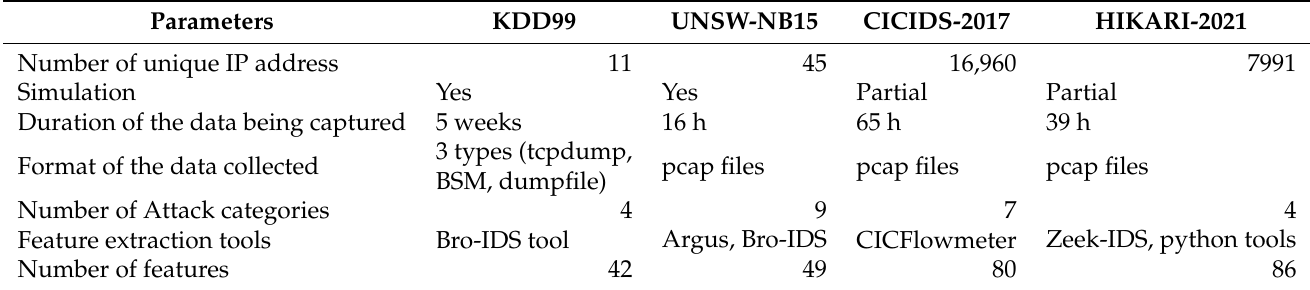
Table 5. The dataset comparison of KDD99, UNSW-NB15, CICIDS-2017, and HIKARI-2021